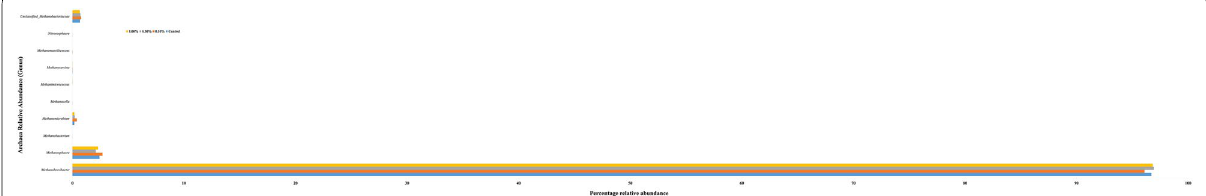
Fig. 3 Archaeal genus‑level compositions of the control and Enterococcus faecium SROD‑supplemented rumen fermenta. The data portray genus‑level 16S rRNA pyrotagged gene sequences. Sequences were classified using the RDP naive Bayesian rRNA Classifier with an 80% confidence threshold. The minor group in the panel is composed of genera showing a percentage of reads < 0.4% of the total reads in all